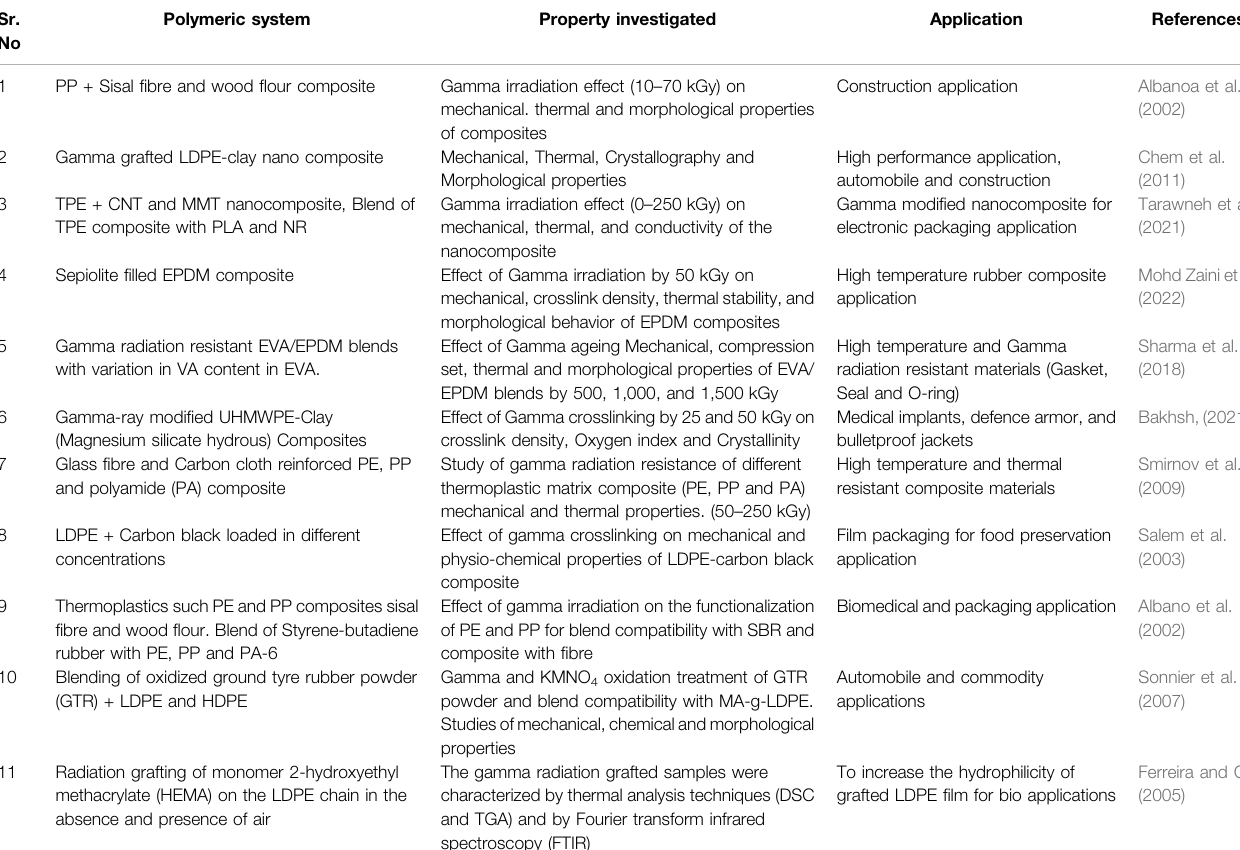
TABLE 2 | Gamma irradiated polymer blends and composites for high end